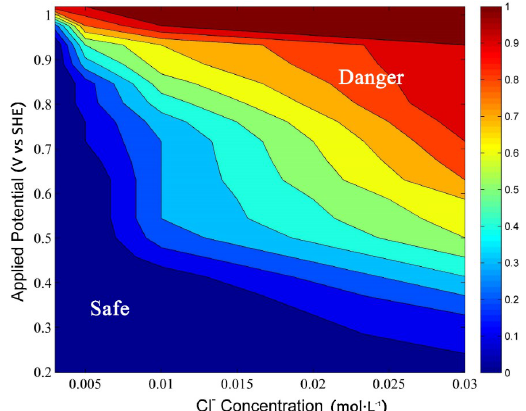
Figure 11. The top viewport of variation of the pitting probability with the potential and Cl − concentration at pH 12.0. The top view direction is on the axis of pitting probability, and the color scale Table 259: wasysym Geometric Shapes indicates the value of the pitting